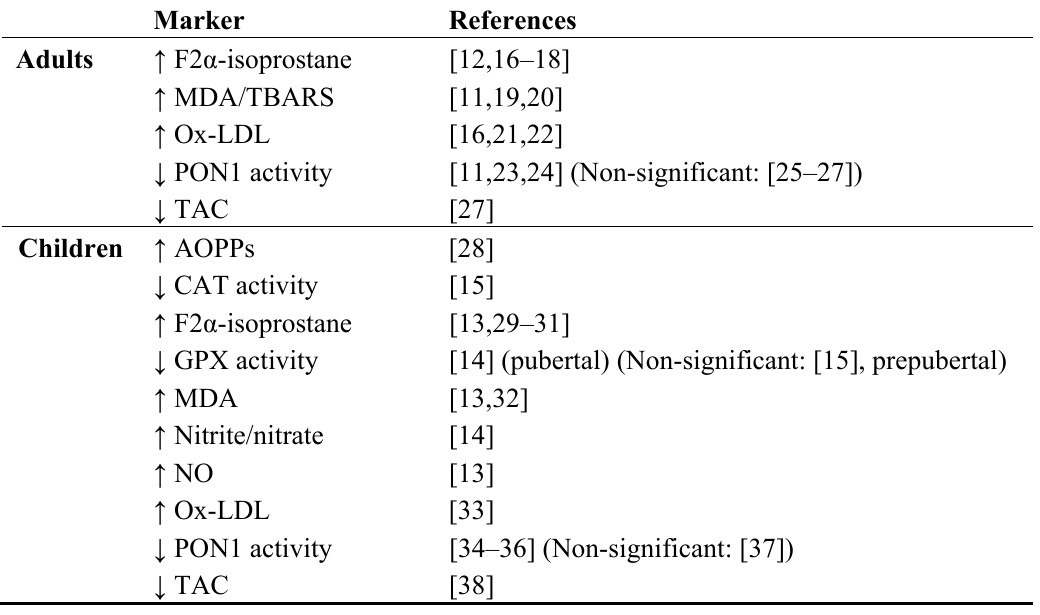
Table 1. Common markers of oxidative stress found in obesity in humans.